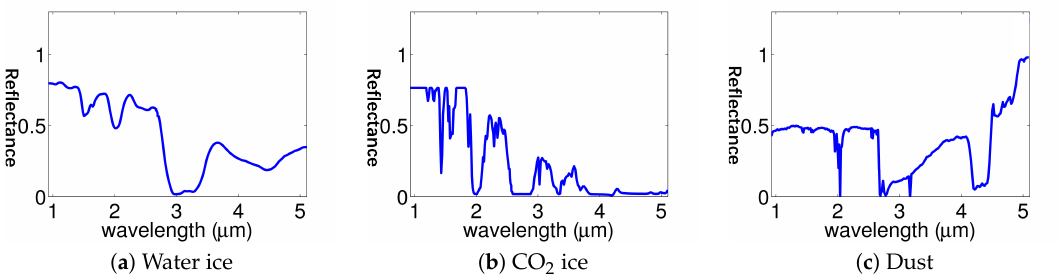
Figure 1. Reference spectra of three typical Mars components calculated by numerical